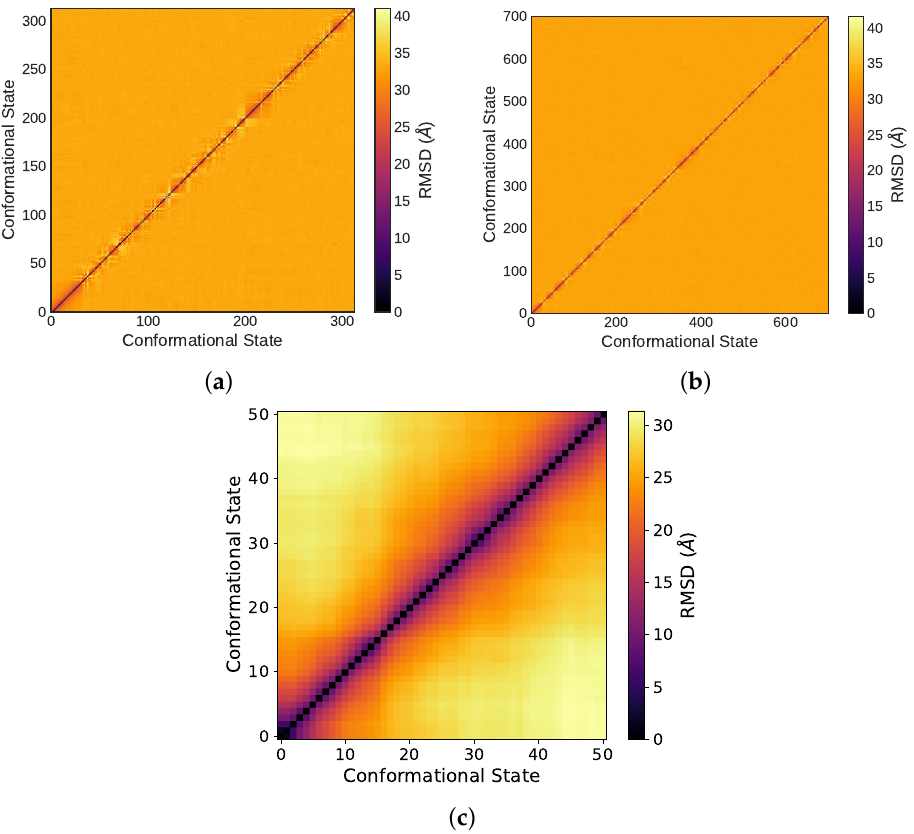
Figure 4. A pure water system at 25 °C and atmospheric pressure: ( a ) 25 ns NPT ensemble runs and ( b ) last 50 ns segment of a 100 ns NVT equilibration following the NPT run. Panel ( c ) presents the all-to-all RMSD plot of a simulation that is further from